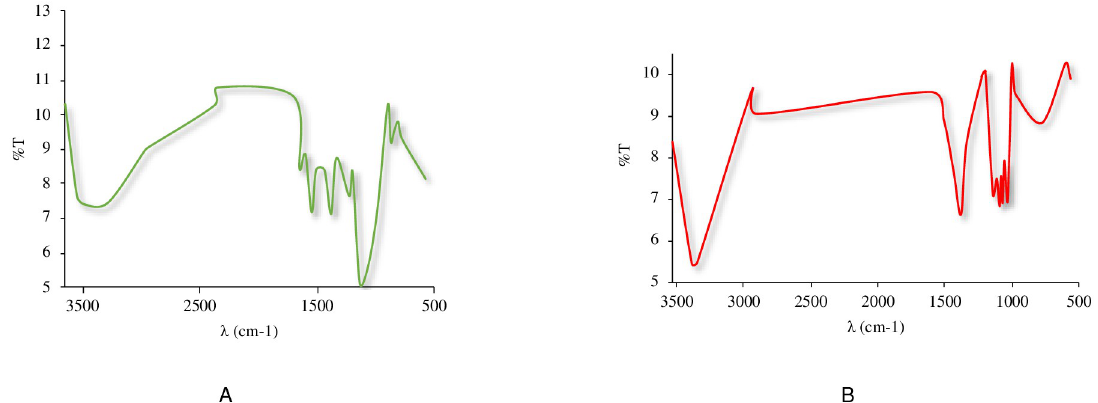
Fig 9. FT-IR binary (1:1) mixtures of rosuvastantin and excipients. (A) Physical mixture rosuvastatin and dibasic calcium phosphate. (B) Physical mixture rosuvastatin and lactose monohydrate.